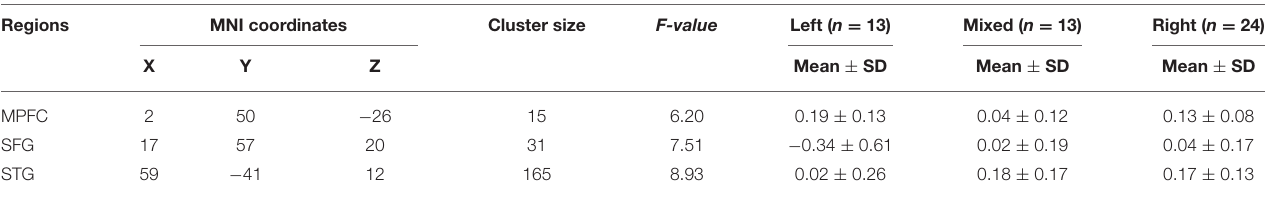
TABLE 3 | Asymmetry index (AI) statistics for the groups.